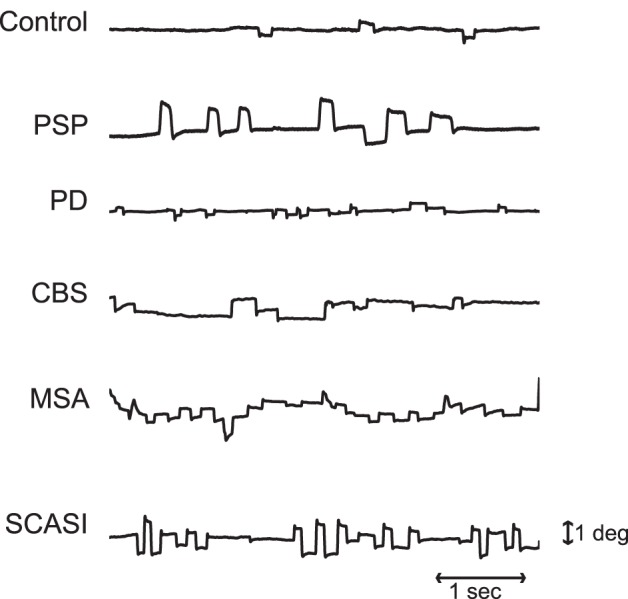
Examples of saccadic intrusions in a control subject, a PSP patient, a PD patient, a CBS patient, a MSA patient and a SCASI patient.SWJs were present in all subject groups, although they were smaller and less frequent in healthy controls. Each trace represents a 5 s recording of horizontal eye positions containing SWJs. Horizontal position and timescales for all traces are as in the bottom trace.